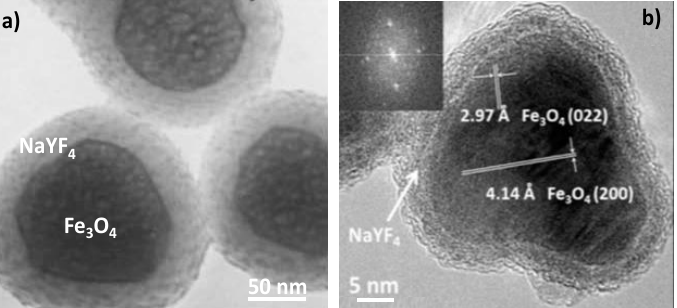
Figure 23. TEM micrographs of representative (a) Fe 3 O 4 @NaYF 4 :Yb 3+ -Er 3+ and (b) Fe 3 O 4 @NaYF 4 :Yb 3+ -Tm 3+ superparamagnetic up-converting core–shell particles. Reproduced from [195] and [230], with permissions from RCS, 2004, and ACS, 2016,